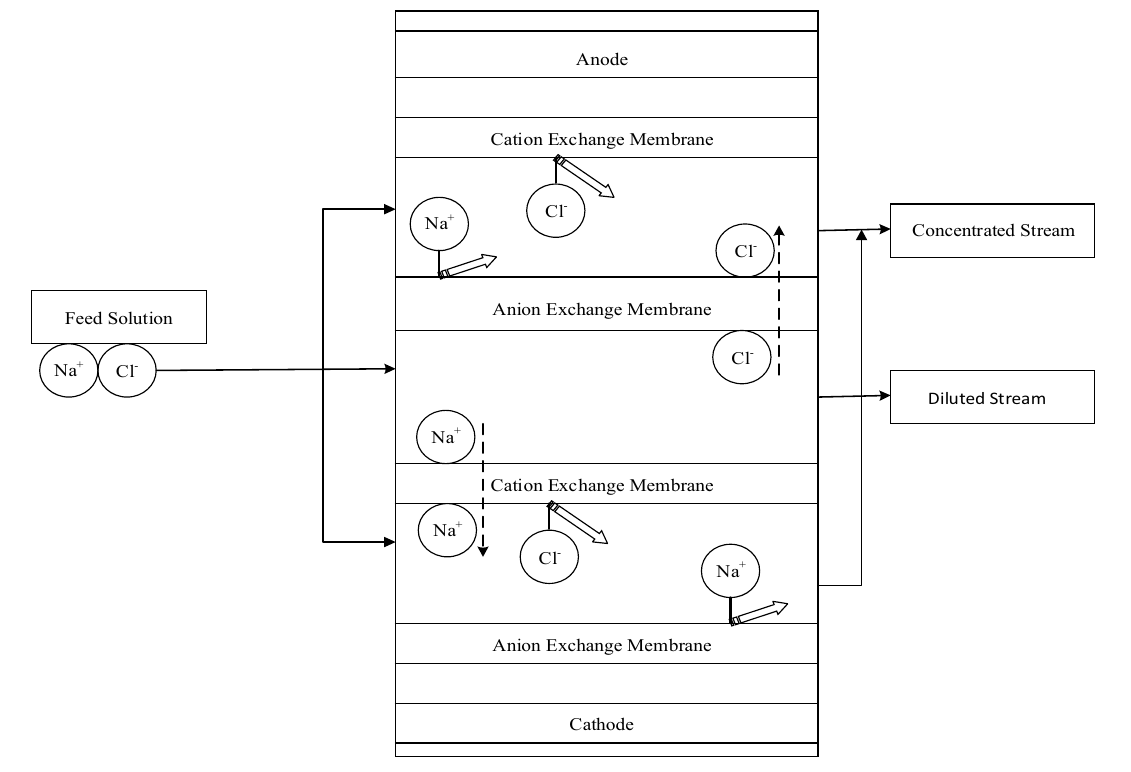
Fig. 5 Process of electrodialysis (Bernardes et al.